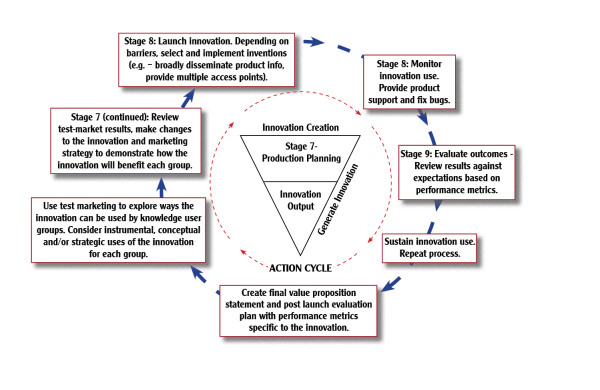
Innovation Outputs.